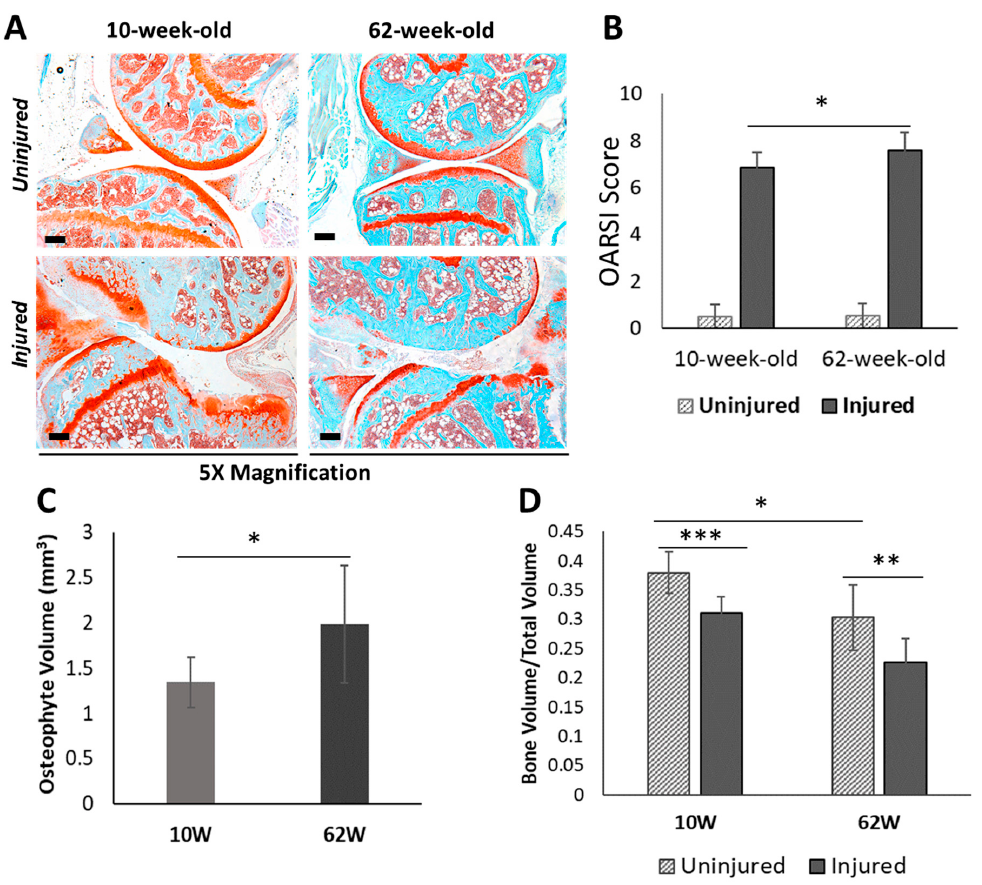
Figure 2. Characterization of post-traumatic osteoarthritis (PTOA)-associated structural changes in 10-week-old and 62-week-old mice. ( A ) Histological evaluation of uninjured contralateral joints and injured joints at six-week post-injury using Safranin-O and Fast Green staining which stains cartilage in red and surrounding tissue in green (5× magnification). Scale bars: 200 µ m. ( B ) Osteoarthritis Research Society International (OARSI) scoring of histological sections of injured and uninjured contralateral joints at six-week post-injury. ( C ) Osteophyte volume at six-week post-injury. ( D ) Epiphyseal trabecular bone volume fraction (BV/TV) of the distal femur was quantified using µCT and analyzed between injured and uninjured contralateral joints at six-week post-injury. 10W: 10-week-old; 62W: 62-week-old. * p < 0.05, ** p < 0.01, *** p < 0.001 .